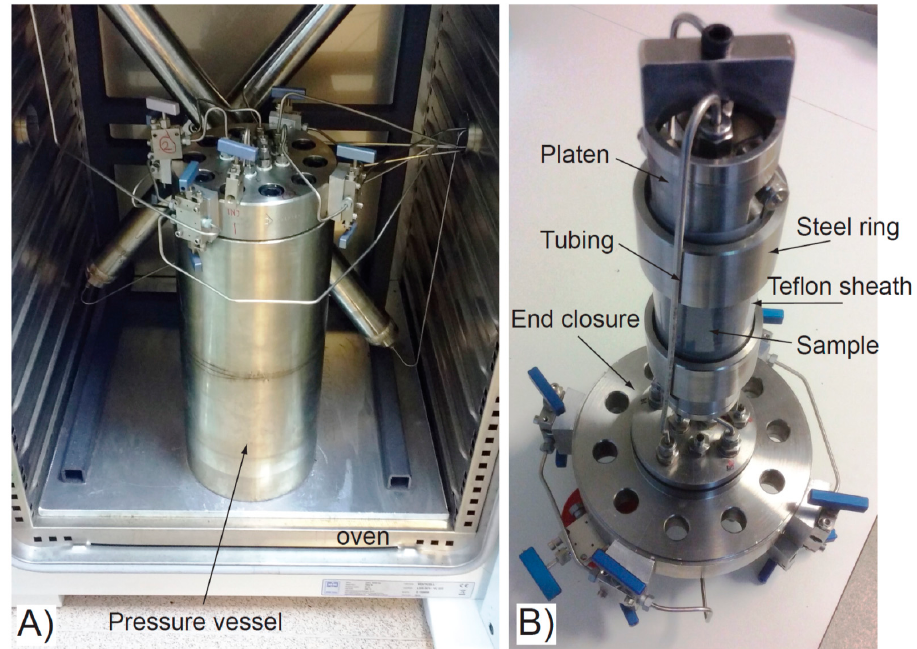
Figure 2. Experimental apparatus for ISO-1 and ISO-2 tests. ( A ) Pressure vessel with end closure and connecting tubing, housed in the test oven; ( B ) Sample assembly. The tubing attaches to the